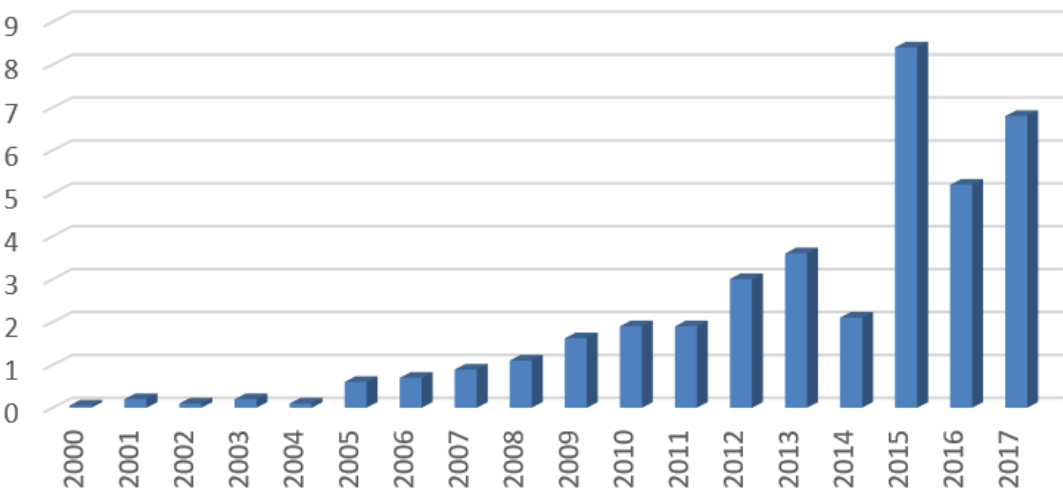
Figure 3. Incidence rate of Lyme disease in the Kharkiv region (per 100 thousands of population). On the territory of Ukraine, including the Kharkiv region, the primary vector of Lyme disease pathogens is the European tick I. ricinus , which dominates the territory of Ukraine. In the most active natural foci of Lyme disease in Ukraine, ticks infected with Borrelia reach